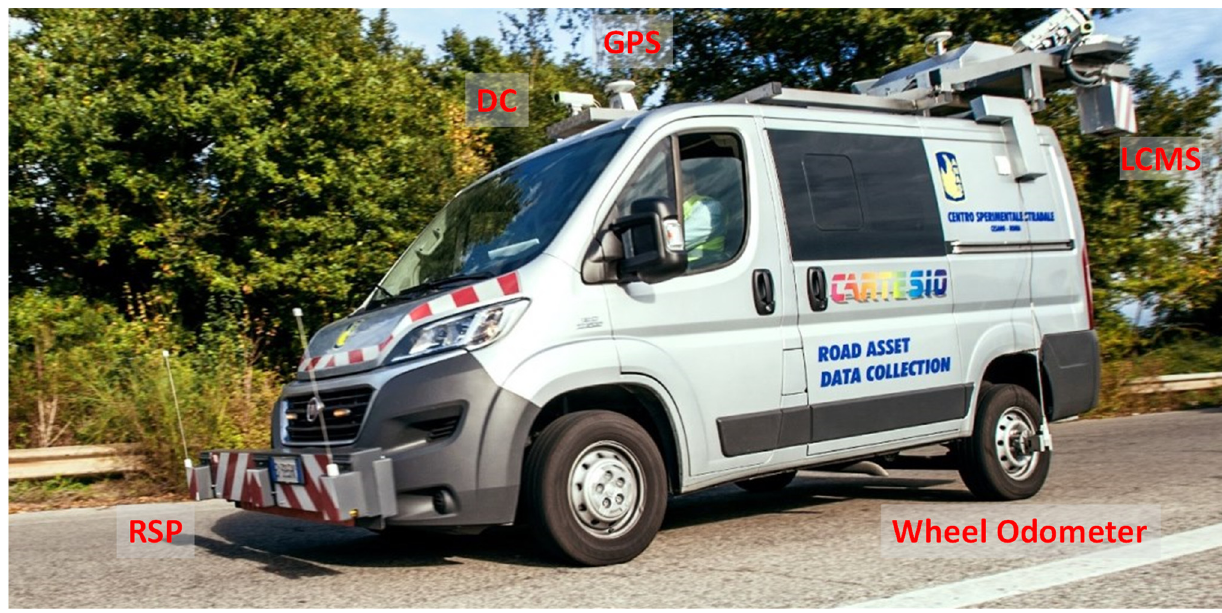
Figure 3. RACS employed for validation and its main components.